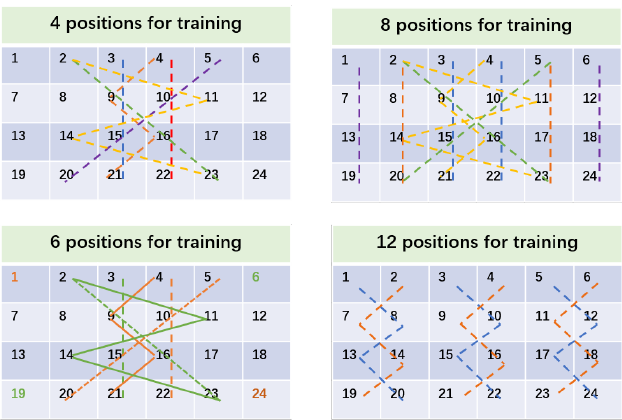
Figure 9. The training location selection strategies. Specifically, for 4/8/12 training locations, the po- sitions where the same colored straight line goes through or the inflection points and the enthesis of the same colored broken lines constitute the training locations. For six training locations, the straight lines or broken lines along with the same colored marked positions form the training locations.